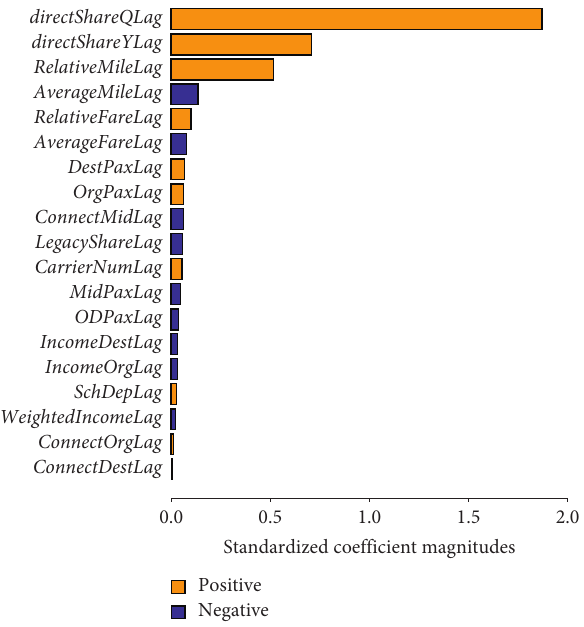
Figure 3: Variable importance of the MLR